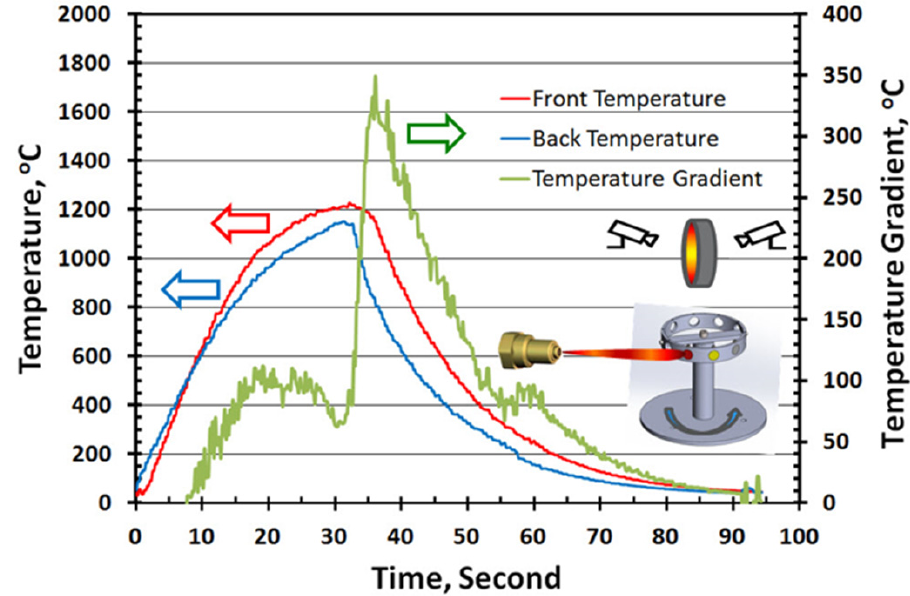
Figure 5. Schematic of the burner rig for thermal shock tests and thermal cyclic temperature profiles, using a high heat flux and high-velocity flame torch.